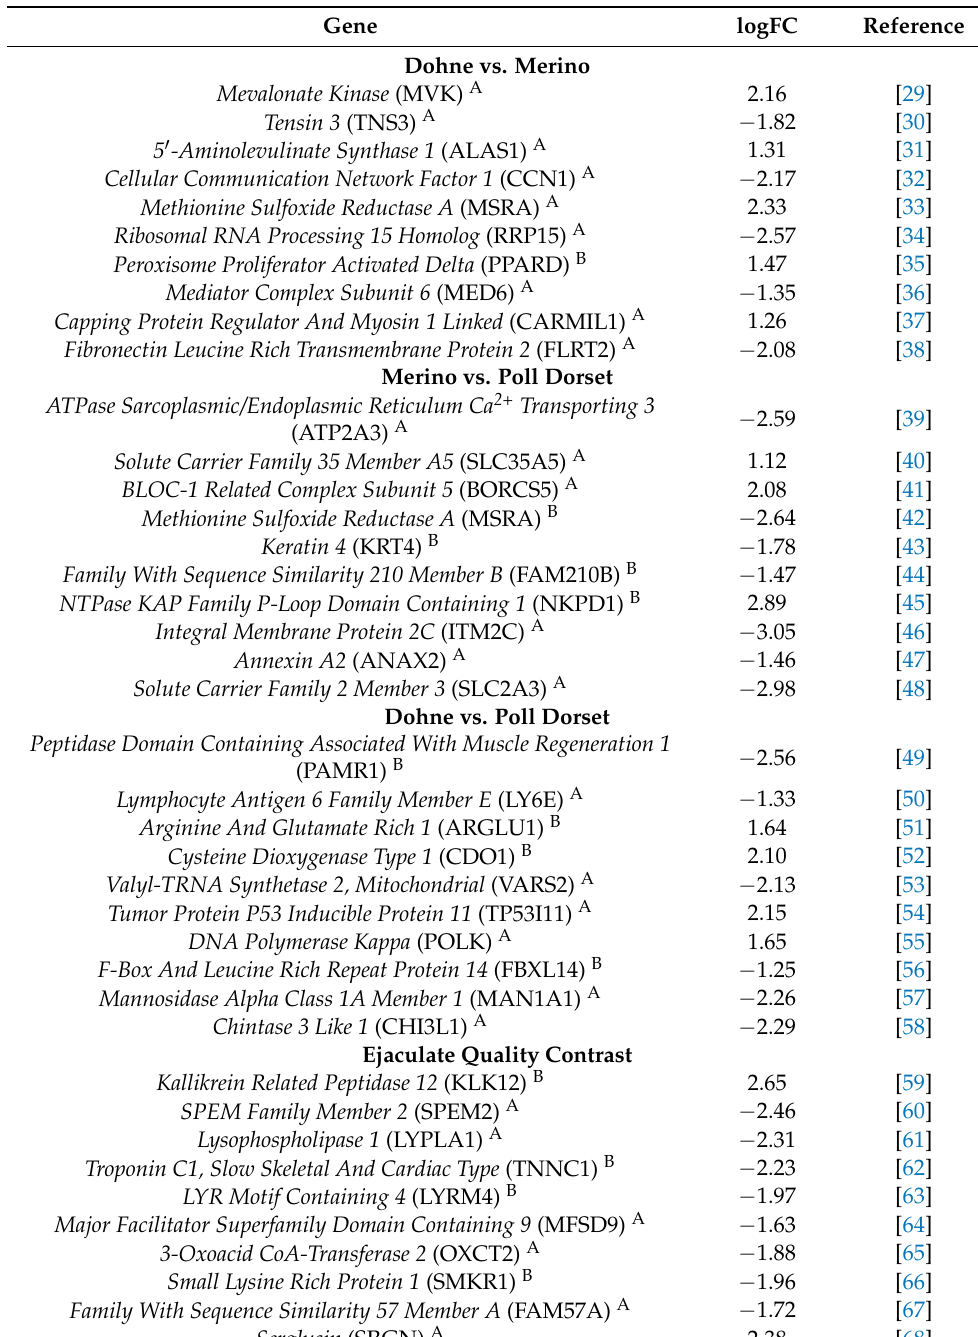
Table 4. List of top 10 differentially expressed genes across the three breeds sampled (Merino, Dohne, and Poll Dorset) and ejaculates of varying